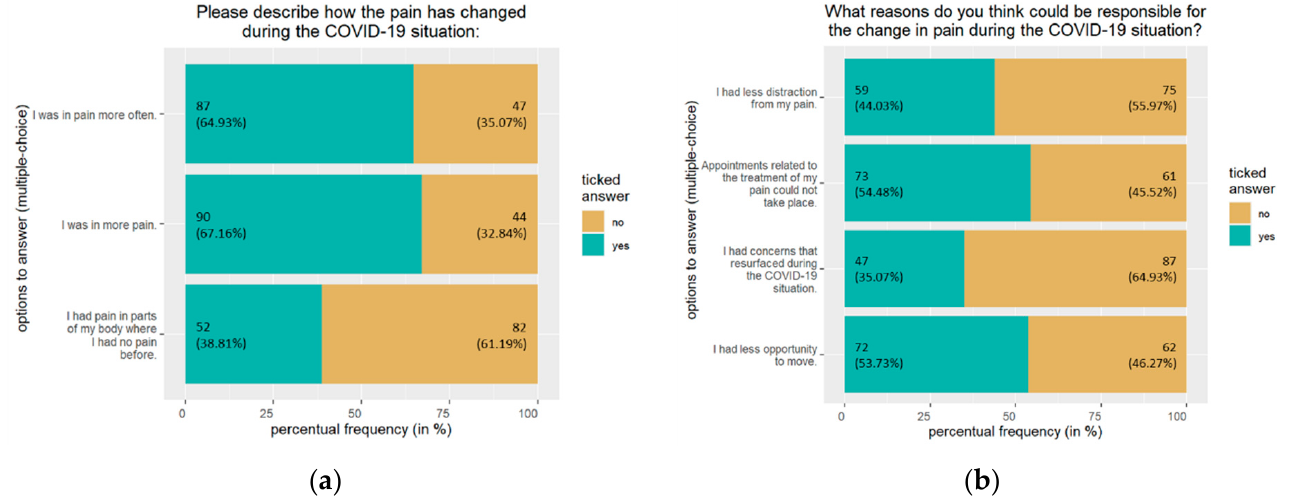
Figure 2. n = 134. The bars show absolute frequency (percentual frequency). Shown above are the participants’ responses regarding ( a ) the change in chronic pain during the COVID-19 situation; ( b ) the possible reasons for the change in chronic pain during the COVID-19 situation.